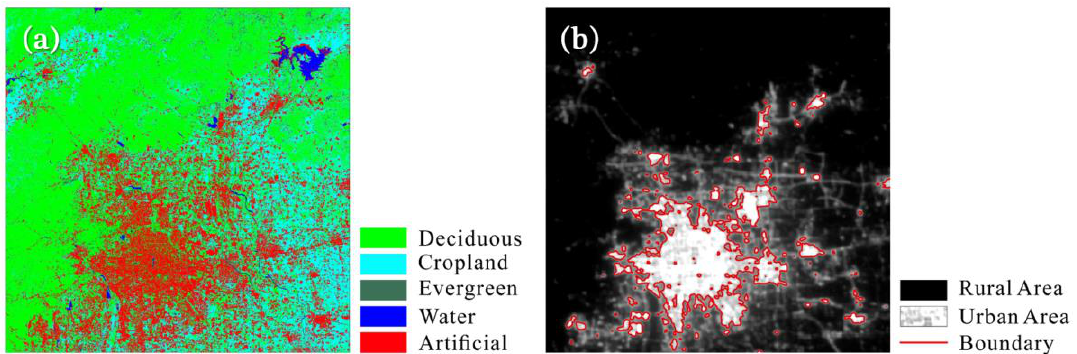
Figure 6. Land cover classification map ( a ) and rural–urban boundary ( b ).